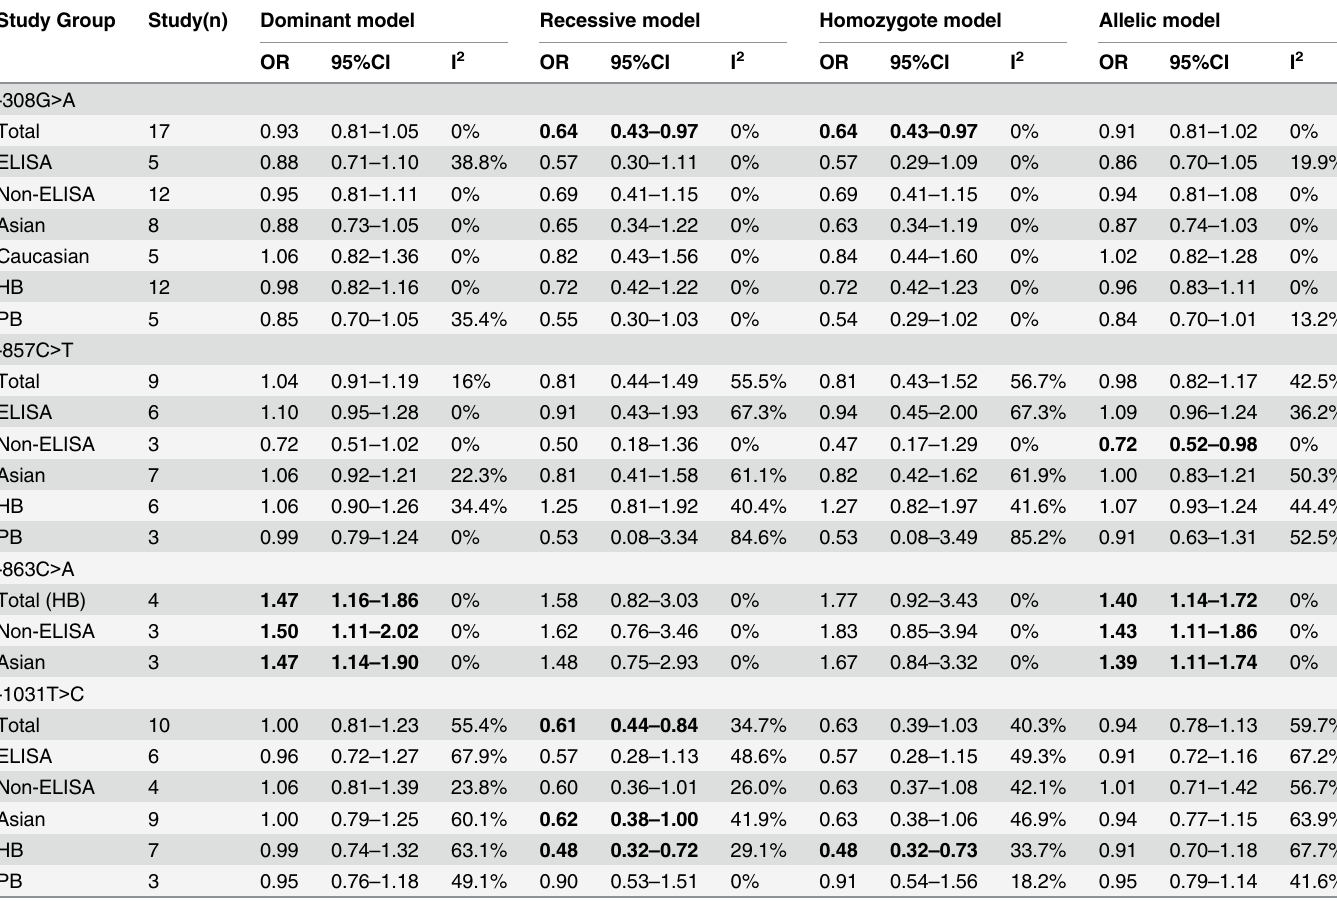
Table 2. Meta-analysis of the association between TNFA polymorphisms and H . pylori